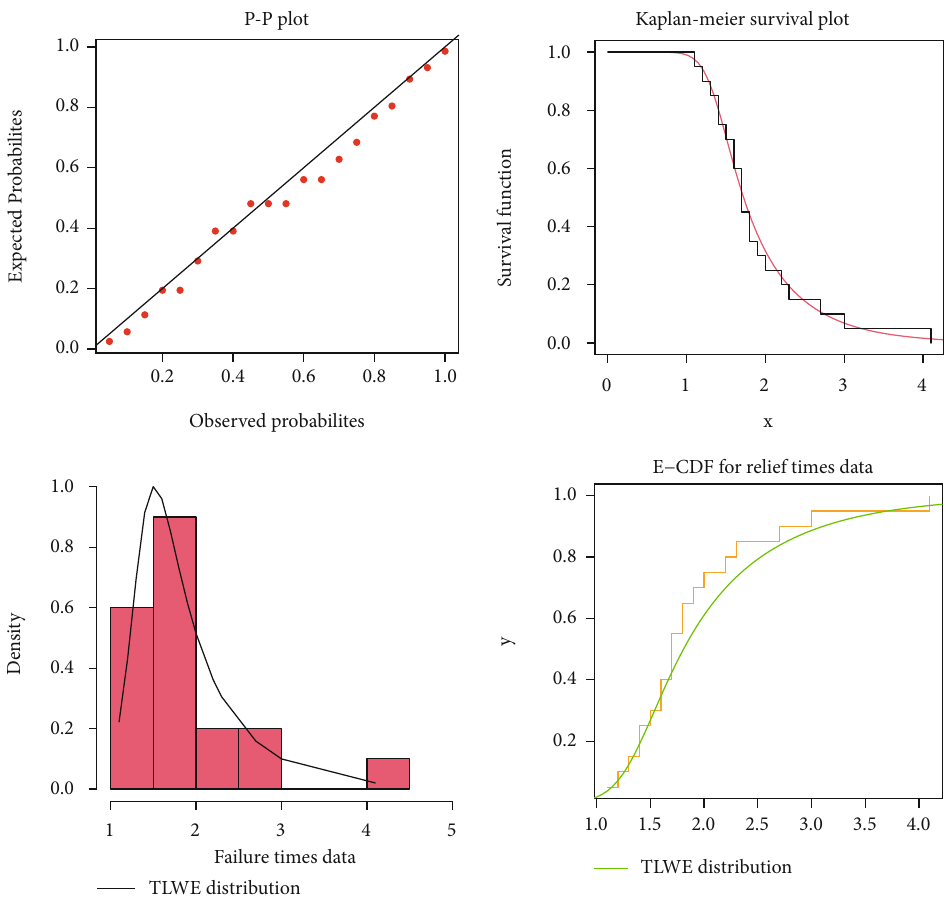
Figure 7: P-P, KMS plot, FPDF, and FCDF for the 1 st